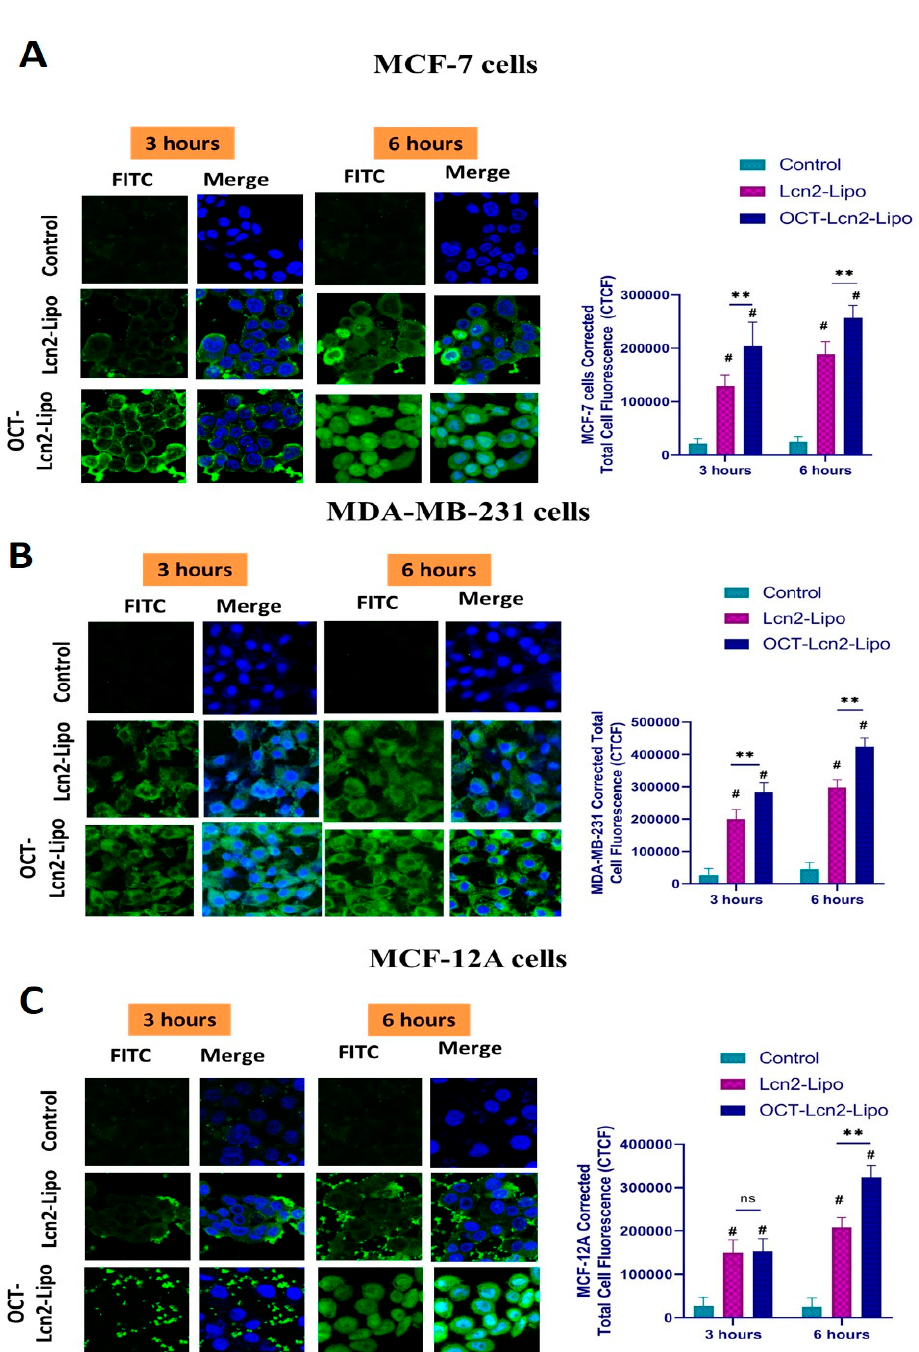
Figure 8. Time-dependent uptake of OCT-Lcn2-Lipo and Lcn2-Lipo prepared with addition of FITC conjugated siRNA. ( A ) Intracellular distribution and corrected total cell fluorescence (CTCF) of OCT-Lcn2-Lipo and Lcn2-Lipo formulation in MCF-7 cells, ( B ) Intracellular distribution and CTCF OCT-Lcn2-Lipo and Lcn2-Lipo solution in MDA-MB-231 cells. ( C ) Intracellular distribution and CTCF OCT-Lcn2-Lipo and Lcn2-Lipo solution in cells.MCF-12A cells. The data were expressed as mean ± SD ( n = 3). (# p ≤ 0.05 as compared to control group, ** p ≤ 0.01 and *** p ≤ 0.001 as compared to Lcn2-Lipo